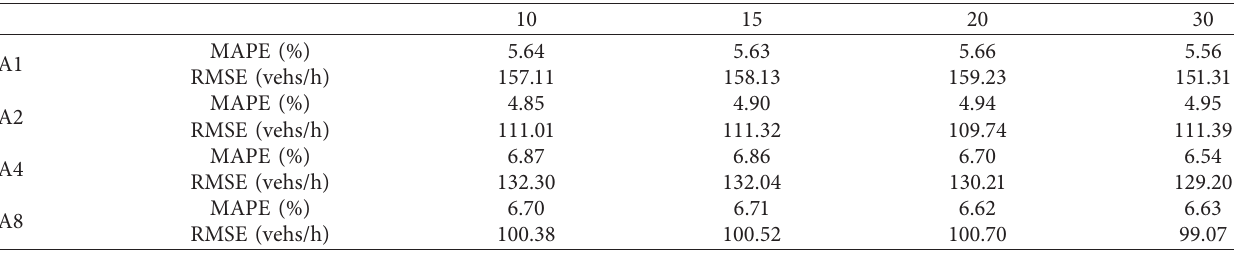
Table 4: The performance of the model in different step size.